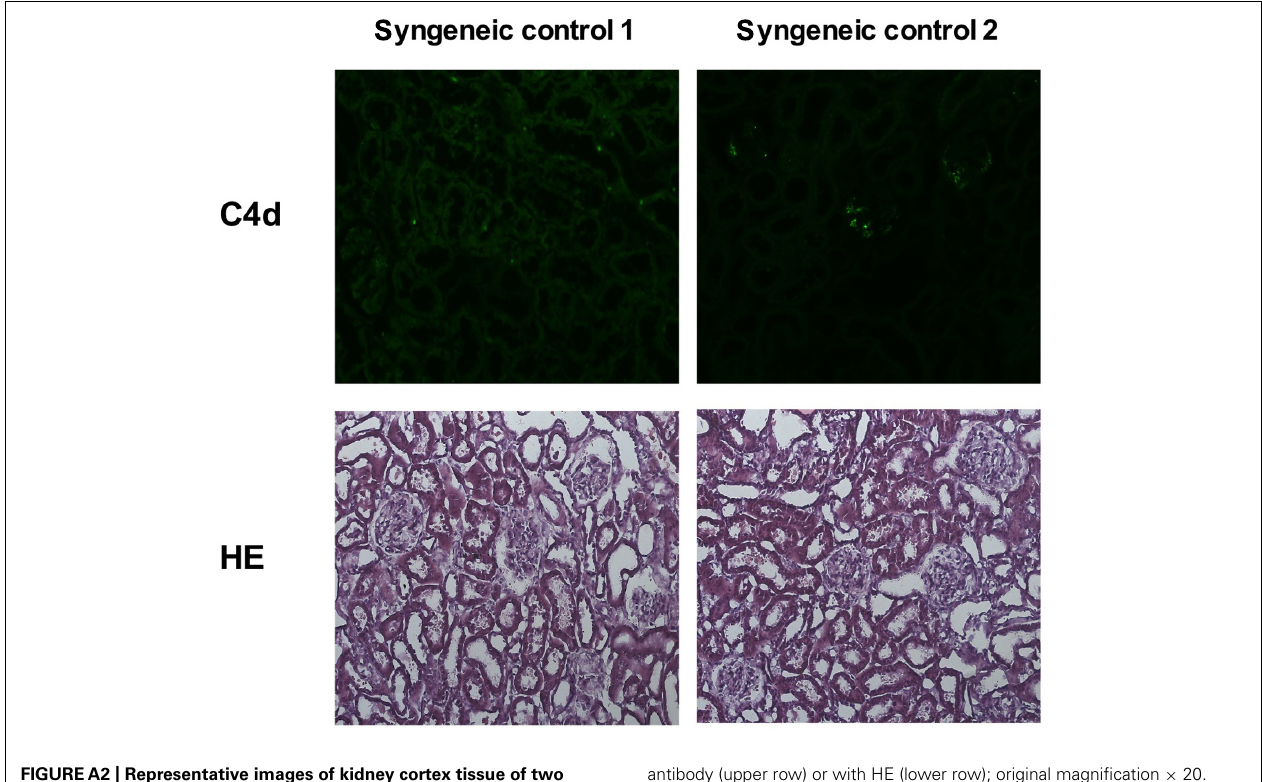
antibody (upper row) or with HE (lower row); original magnification × 20. Both rats show a normal kidney cortex architecture and lack specific C4d